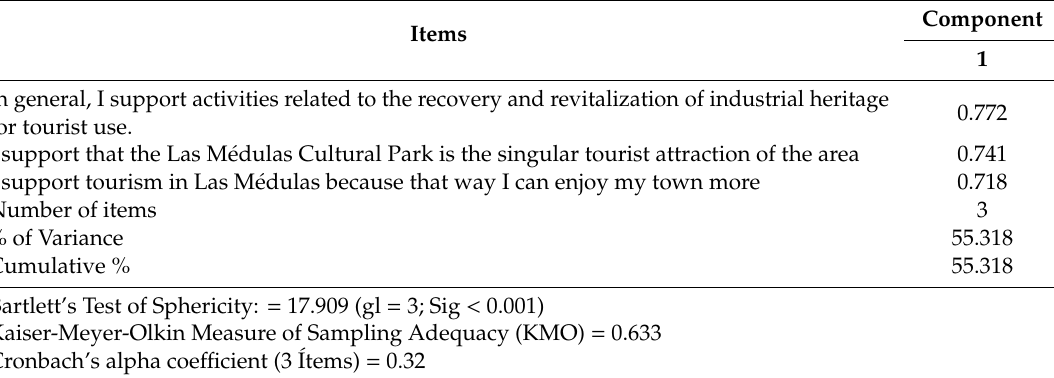
Table 6. Scale measuring resident’s support for tourism (one-dimensional) Source: Author´s